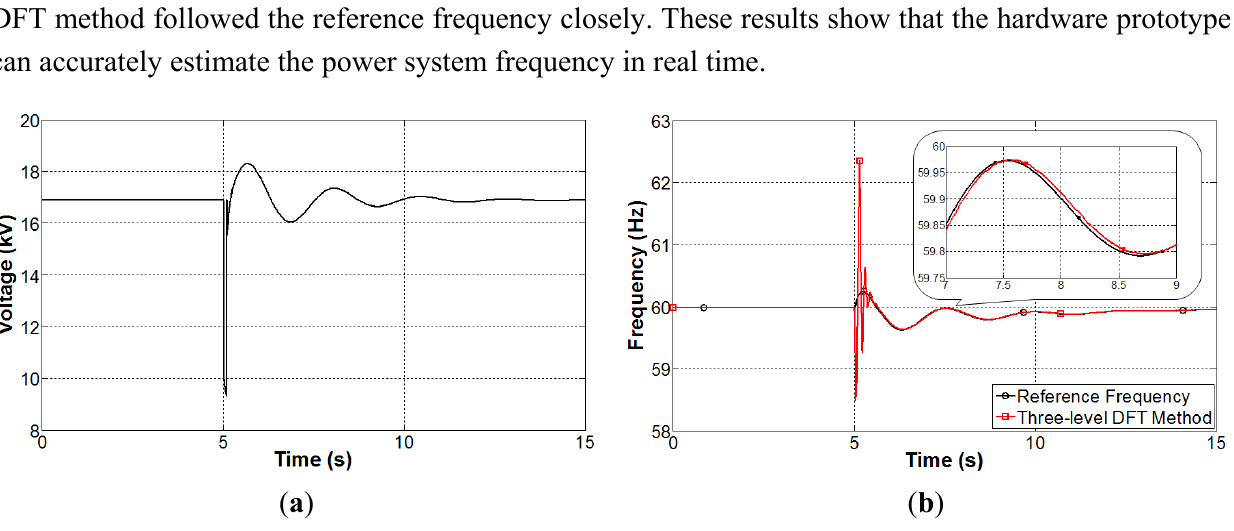
Figure 12. Estimation of the power system frequency when a single line-to-ground 0° fault occurred. ( a ) Terminal voltage of generator A; ( b ) Estimated